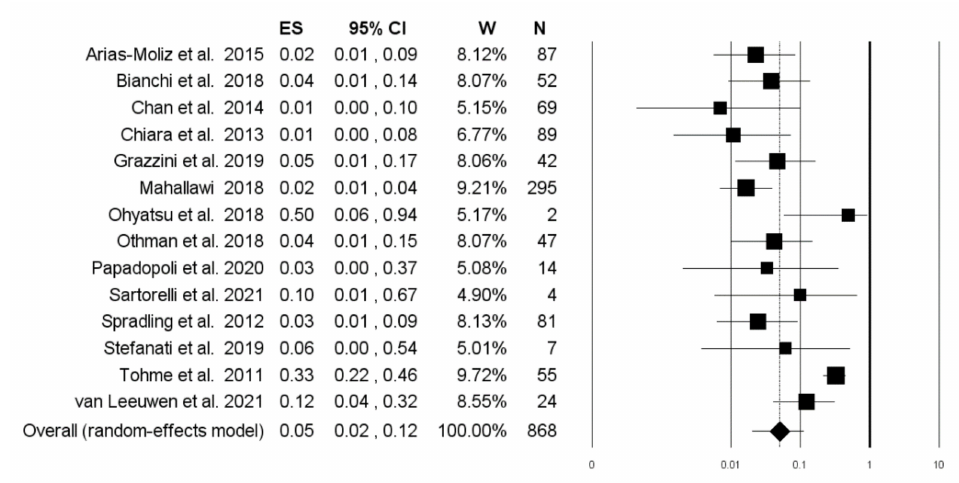
Figure 8. Forest plot of the prevalence of subjects not responding to the completion (fifth and sixth dose) of the second vaccination